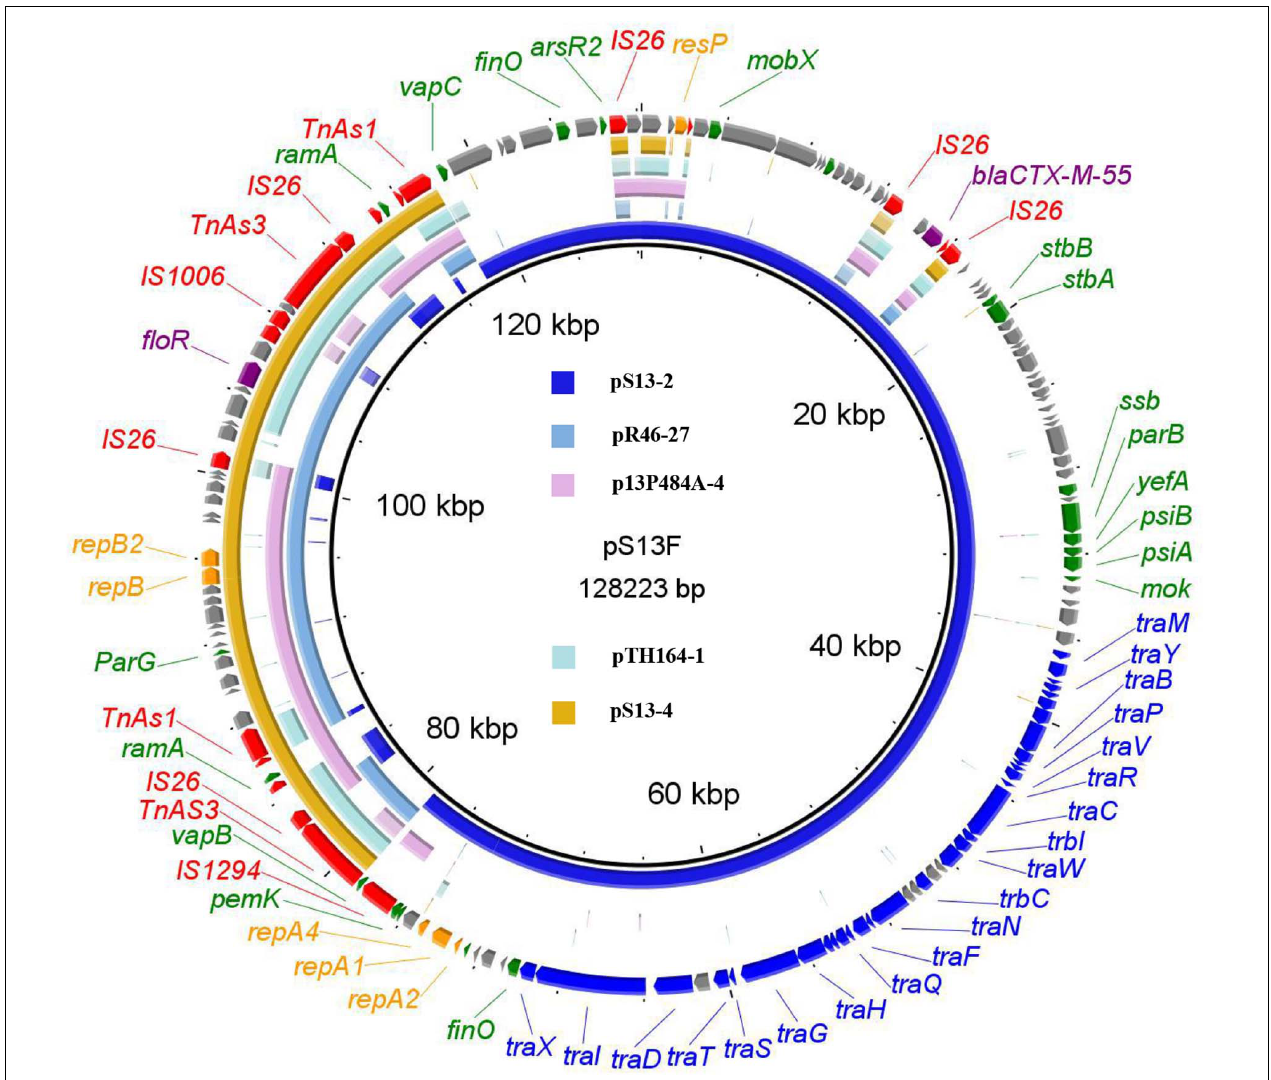
FIGURE 3 | The whole-plasmid sequence of pS13F, comparison of pS13-2 and pS13-4 with similar plasmids. The outer ring comprises the CDSs of pS13F. The plasmids in this study included pS13F (MT742153), pS13-2 (CP047092), pS13-4 (CP047094), pR46-27 (CP035774), p13P484A-4 (CP019284), and pTH164-1 (CP035212). Key features of pS13F are highlighted in the same color as the pS13D.